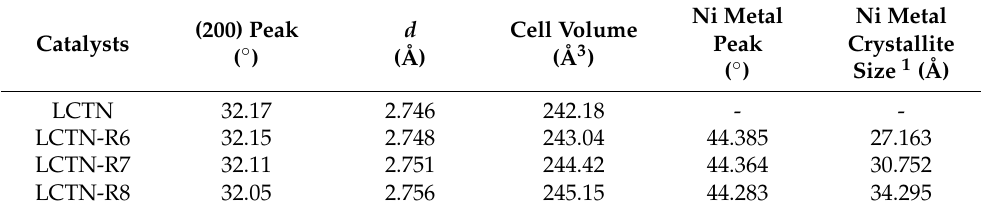
Table 1. Crystalline characterization from XRD results.